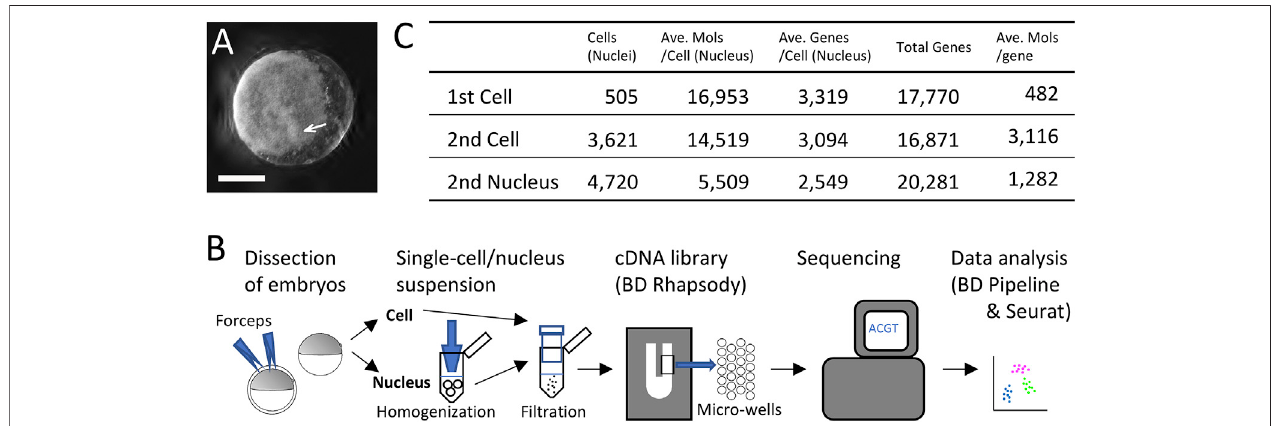
FIGURE 1 | Single-cell and single-nucleus transcriptomics of the early spider embryo. (A) An embryo at late germ-disc stage (late stage 5). The germ disc is observed as the white sheet. The arrow indicates the cumulus. Scale Bar = 200 μ m. (B) Diagram showing single-cell and single-nucleus experimental procedure. (C) Metrics summary after fi ltering out low-quality cells (nuclei). Numbers of cells and nuclei examined in the fi rst single-cell, the second single-cell, and the single-nucleus analyses,averageofdetectedmoleculespercell(nucleus),averageofdetectedgenespercell(nucleus),totalnumbersofdetectedgenes,andaverageofdetected molecules per